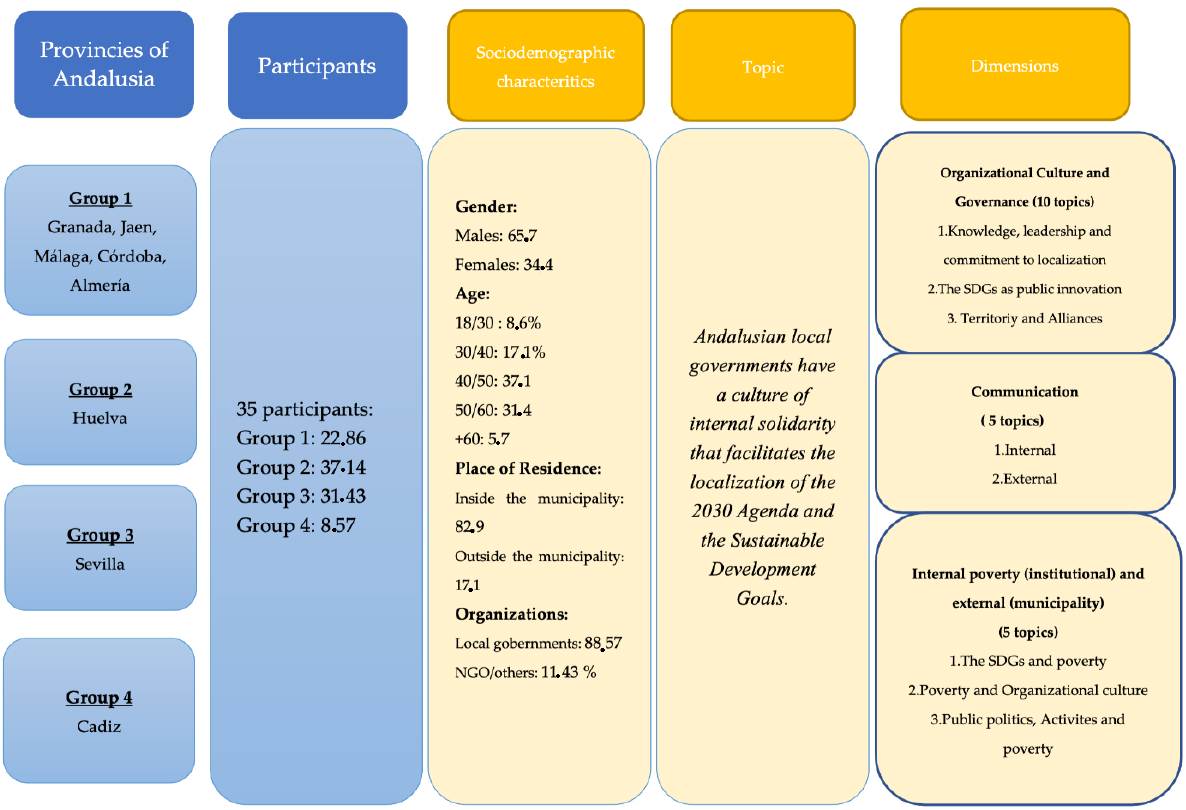
Figure 2. Chart diagram of the research design.